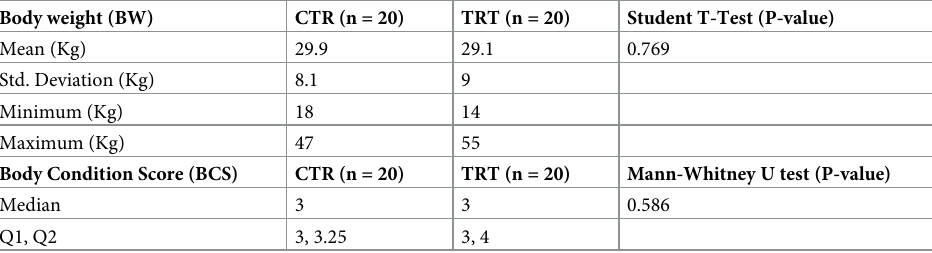
Data are expressed as mean and standard deviation for the BW; median, first (Q1), and third (Q3) quartiles for BCS. Differences between groups are calculated using Student T-Test (BW) and Mann-Whitney U test